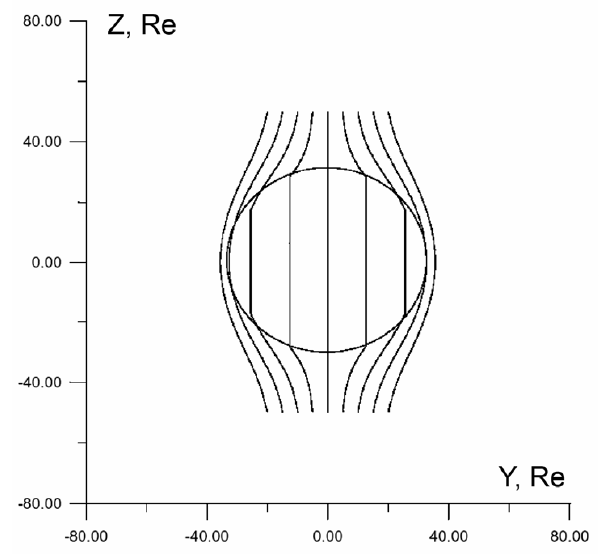
Fig. 3. A projection of the IMF lines on the plane x = R 1 / 2 (where Figure 3. A projection of the IMF lines on the plane 2/ Rx = (where the paraboloid focus is 1 the paraboloid focus is located) is shown. We see the draping of located) is shown. We see the draping of the magnetic field lines. As a result, the IMF penetrated the magnetic field lines. As a result, the IMF penetrated into the into the magnetosphere, b = κ B B , is only a small part of the IMF upstream of the bow shock. magnetosphere, b = κ B B , is only a small part of the IMF upstream The factor κ B is about 0.1 ( Alexeev , 1986), and it describes the weakening of the IMF inside the of the bow shock. The factor κ B is about 0.1 (Alexeev, 1986), and magnetosphere. it describes the weakening of the IMF inside the